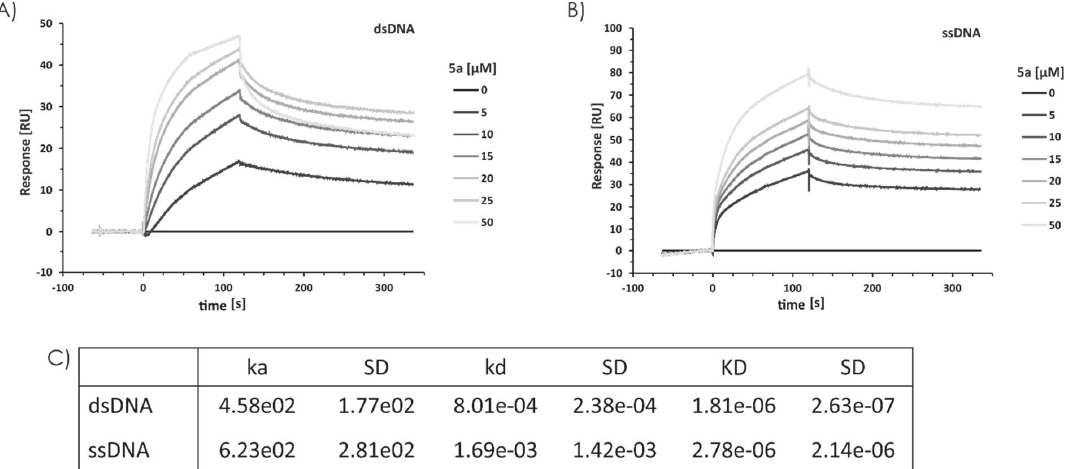
Figure 3S. Surface plasmon resonance SPR analysis of double ‐ stranded DNA (dsDNA) binding by various peptidomimetics. The SPR analysis of dsDNA binding was performed using: A) 50 μ M and B) 100 μ M of the indicated compounds, flowed over the SA sensor chip surface with immobilized 76 bp biotinylated DNA fragment containing the sequence of beta ‐ actin ( Homo sapiens ). Injections were performed in HBS ‐ EP buffer. HBS ‐ EP was also used as the running buffer.